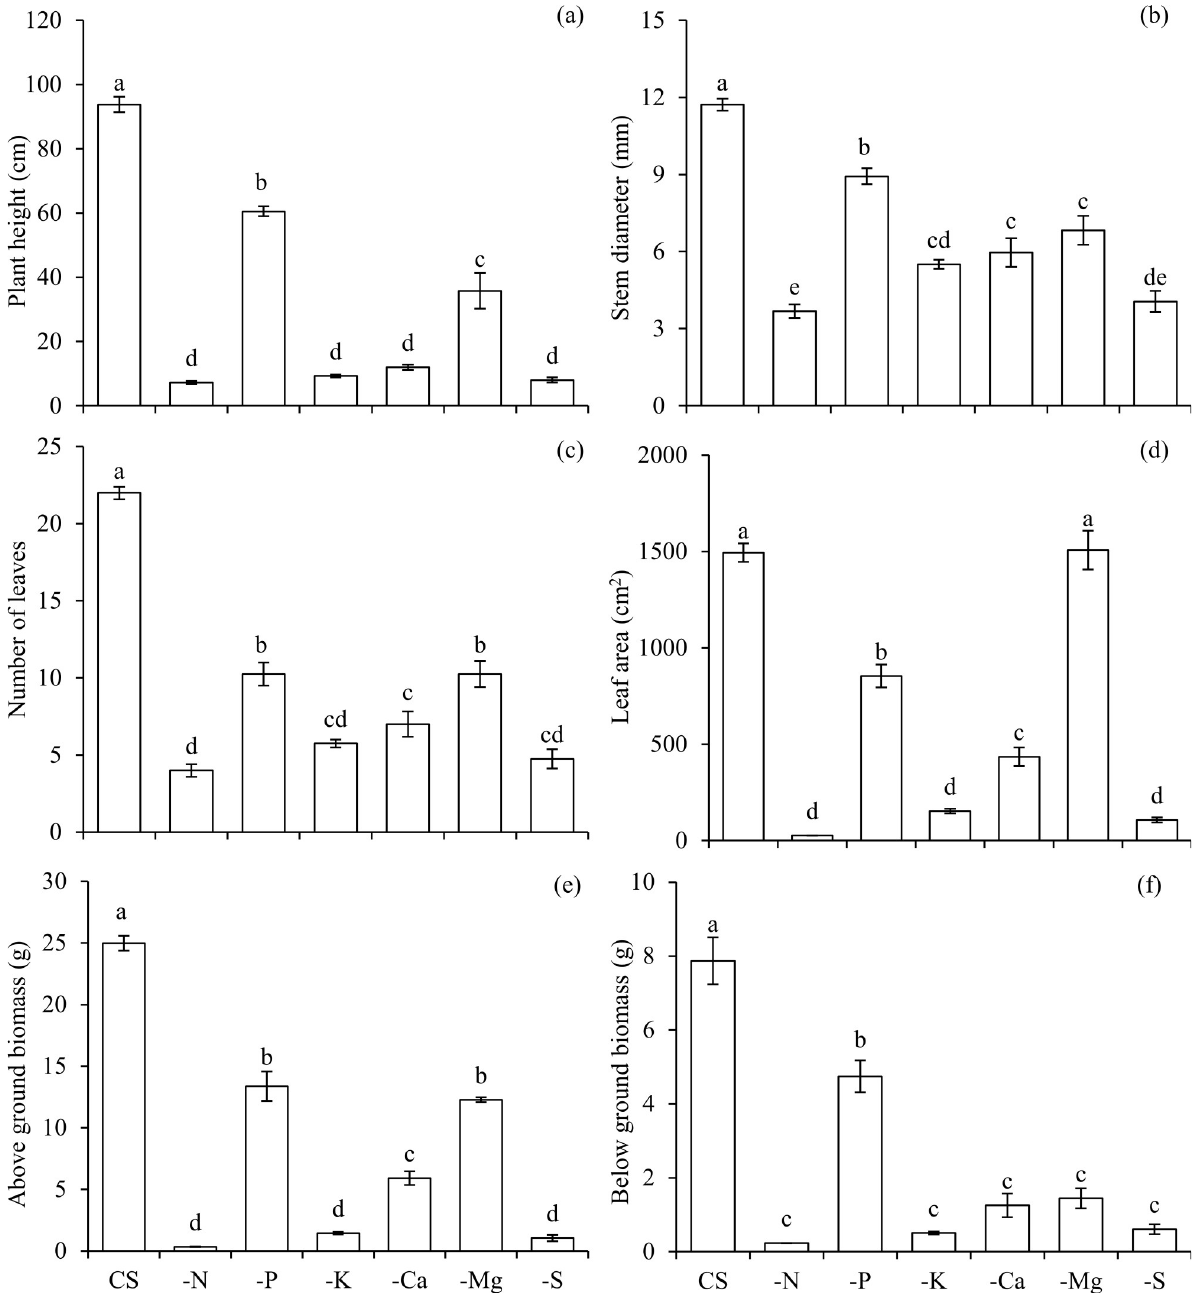
Fig 5. Plant height (a), stem diameter (b), number of leaves (c), leaf area (d), above ground biomass (e), and below ground biomass (f) in scarlet eggplants in complete solution (CS), and under omission (-) of macronutrients ( − N, − P, − K, − Ca, − Mg, and − S). Means followed by the same letter in each bar did not differ from each other by the Tukey’s test (p � 0.05). Bars represent the standard error of the